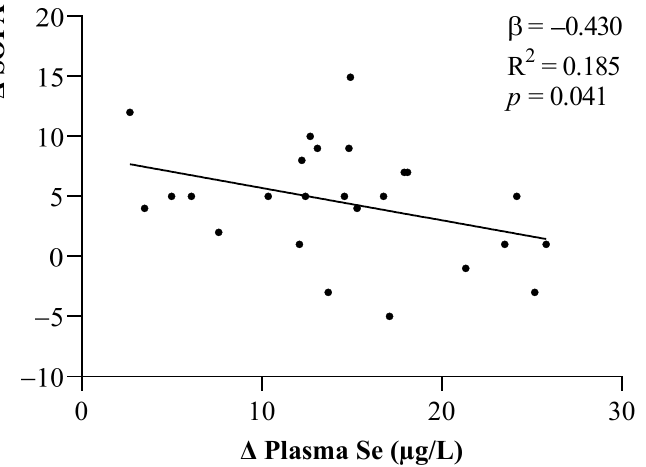
Figure 2. Relationships between the changes in plasma and erythrocyte Se expressed in µg/L ( a ) and µg/g Hb ( b ) after one week of ICU stay. Abbreviations: Hb = Hemoglobin; Se = Selenium. The β (standardized regression coefficient) and p -values from single linear regression analyses were obtained. Statistical significance was considered for p < 0.05.